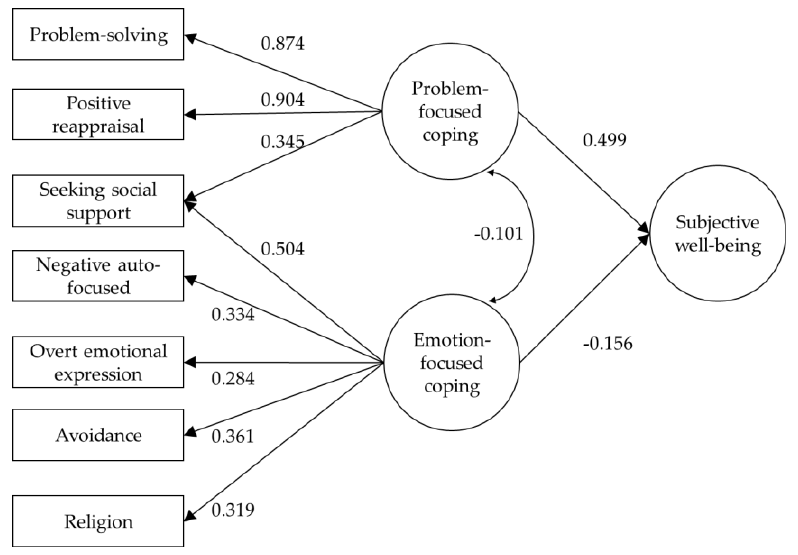
Figure 1. Final model.